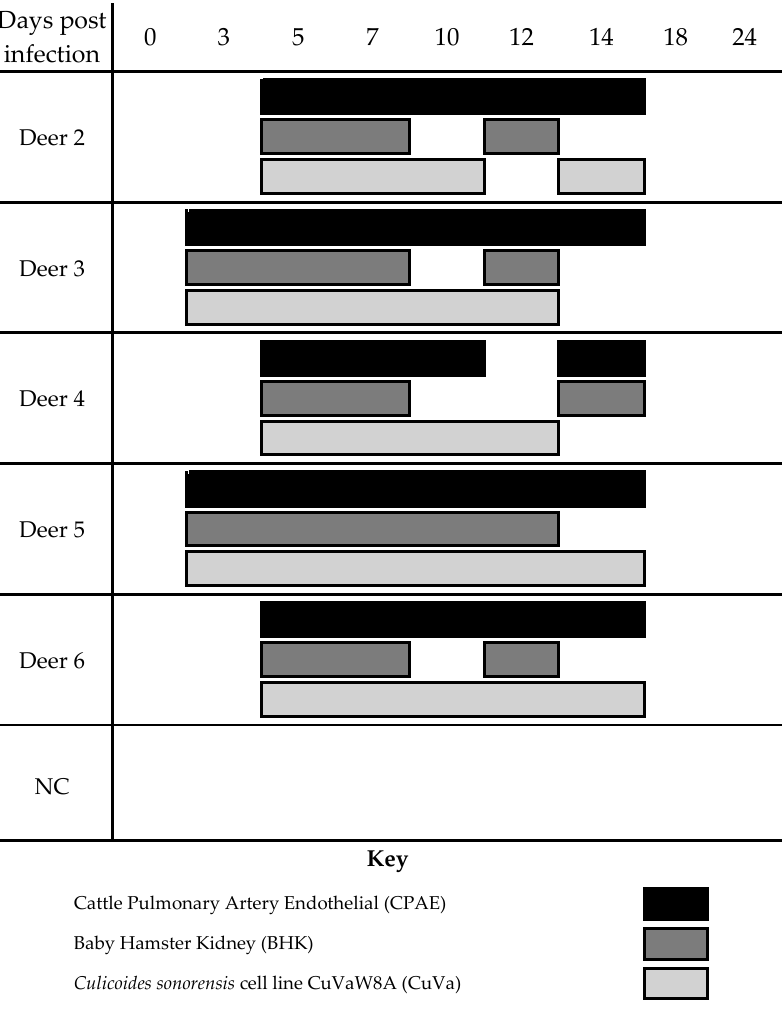
Figure 3. Evaluation of cell lines for EHDV diagnostics. Virus isolation from blood of deer was attempted on three di ff erent cell lines at di ff erent time points throughout the study. Shaded cells indicate positive virus